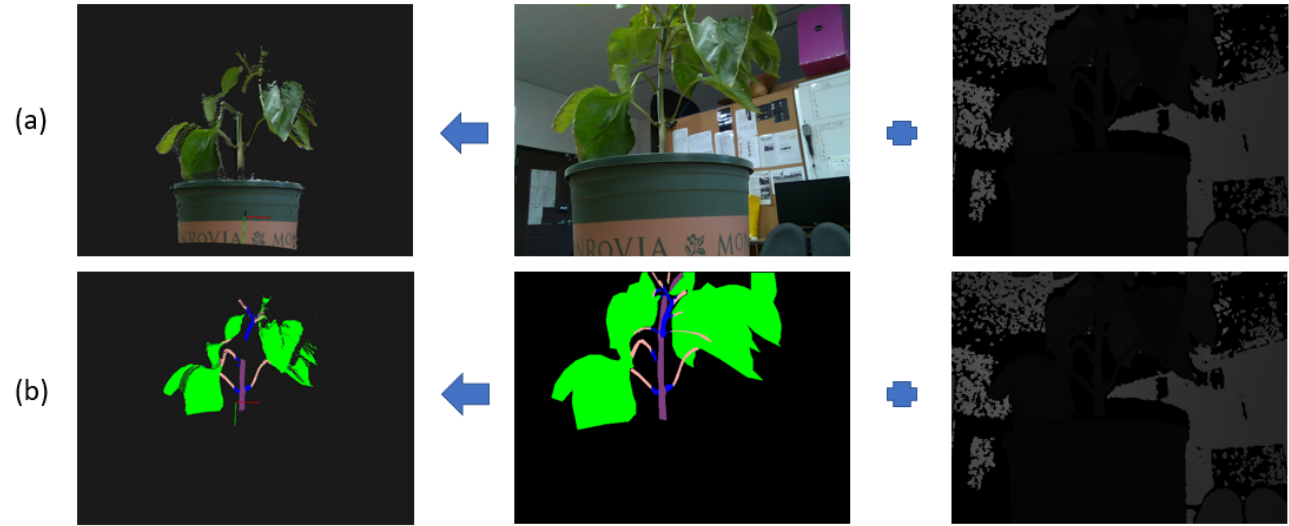
Figure 6. Two point clouds created from a sweet pepper plant. ( a ) 3D normal point cloud created from an RGB and depth image. ( b ) 3D semantic point cloud created from semantic and depth images. The red and green lines represent X and Y axes in a 3D coordinate system.